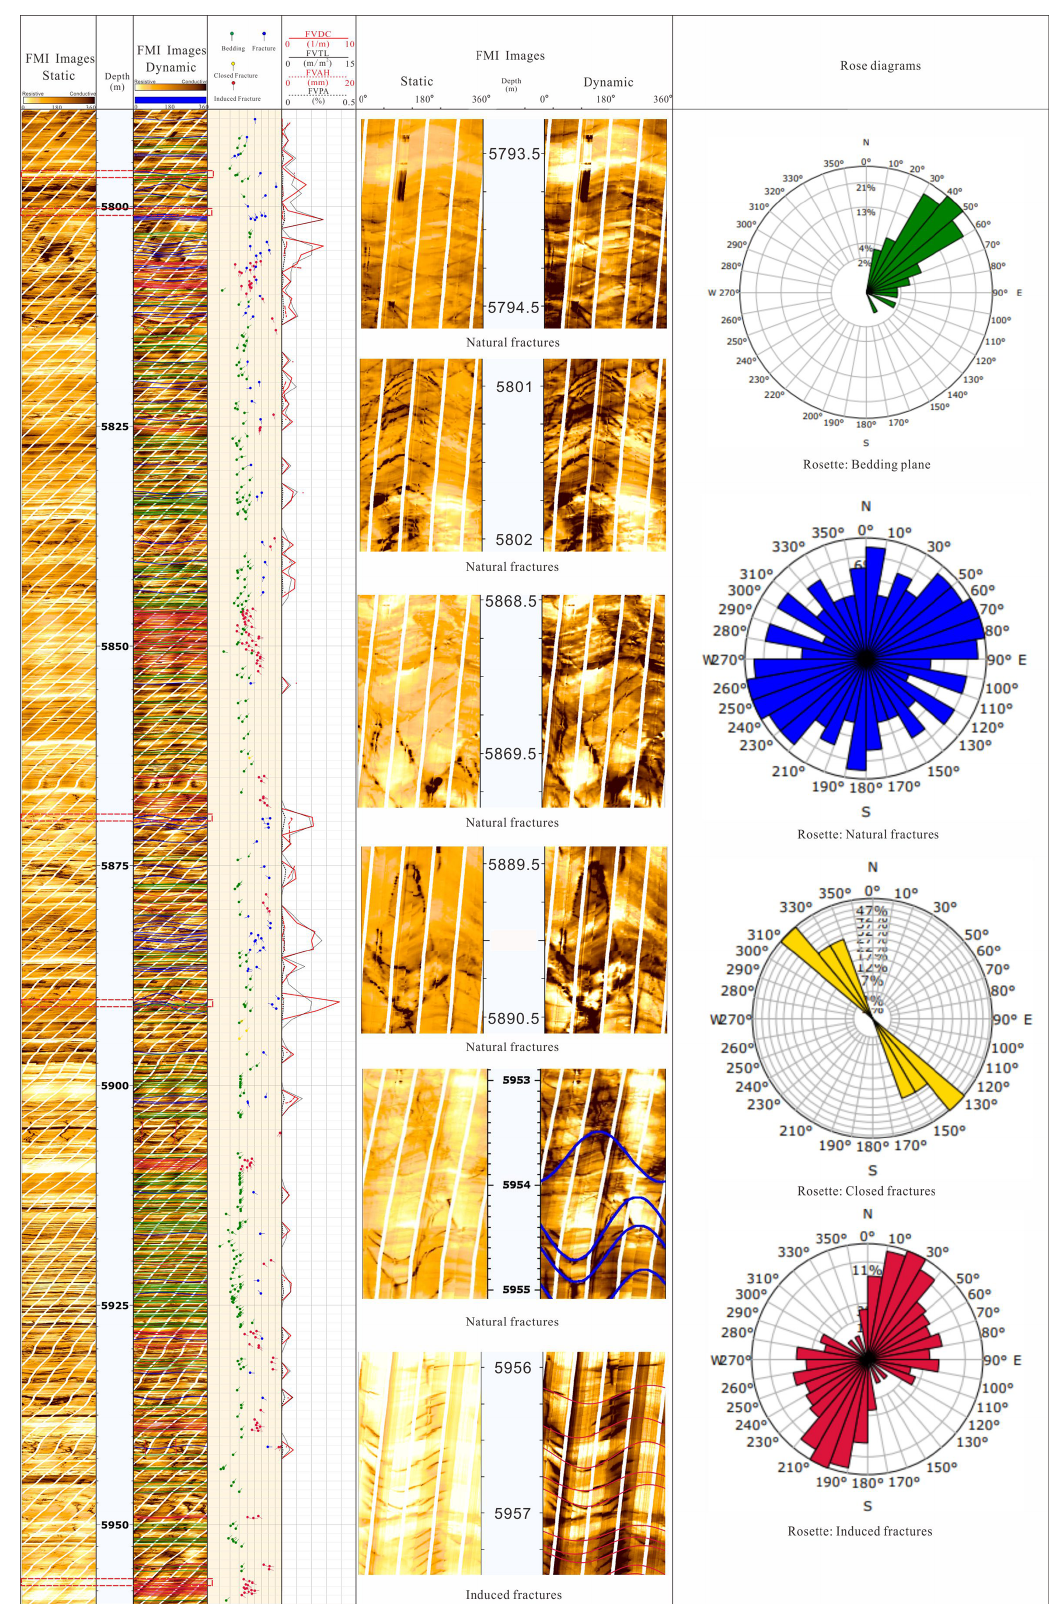
Figure 9. Comprehensive evaluation of natural fractures, induced fractures and fracture effectiveness using image logs for Dabei 1101. https://doi.org/10.5194/se-13-975-2022 Solid Earth, 13, 975–1002,